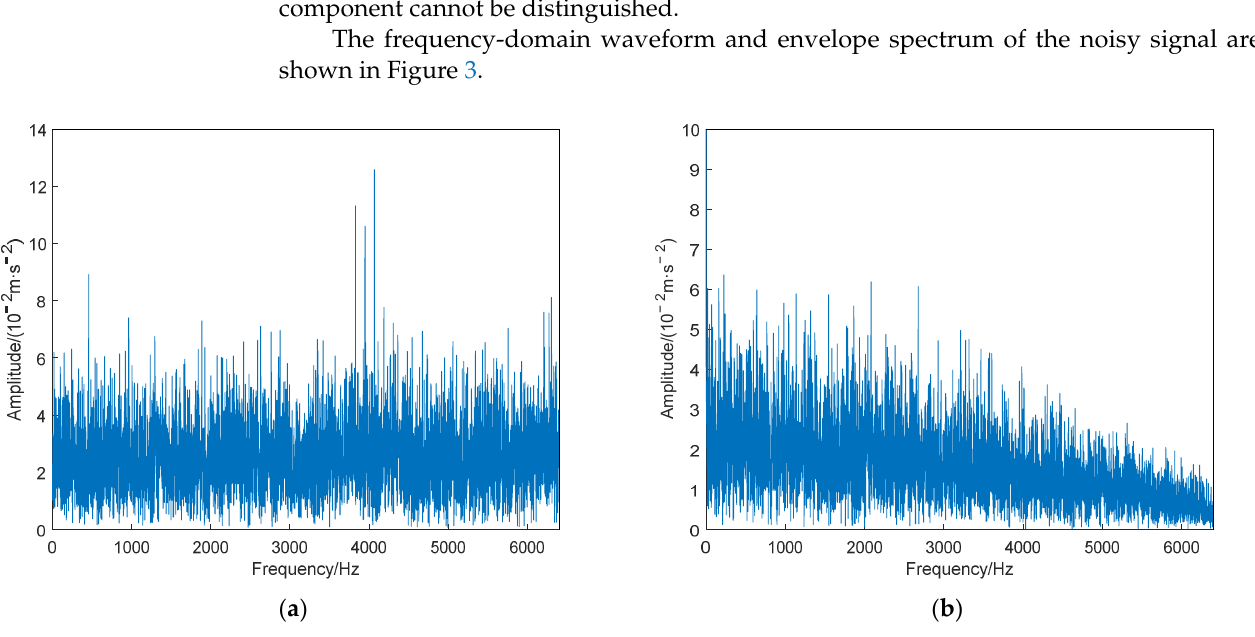
Figure 3. Frequency-domain waveform and envelope spectrum of the noisy signal: ( a ) frequency- domain waveform with noisy signal; ( b ) Envelope spectrum of noisy signal.